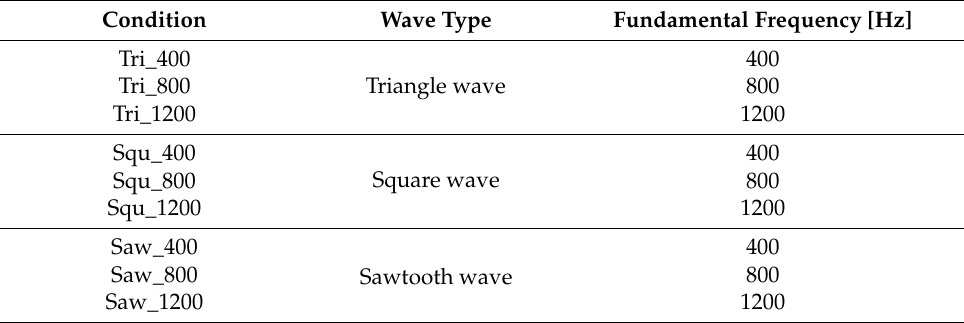
Table 2. List of the warning sounds adopted in Phase 1 of the present study.